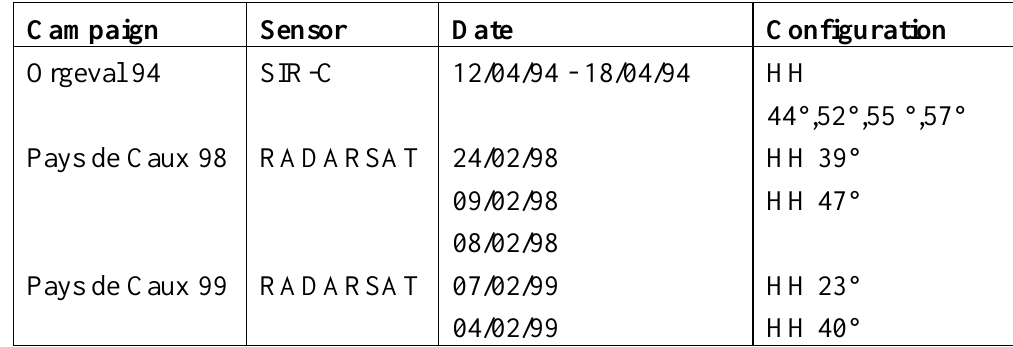
Table 1. Details of radar data